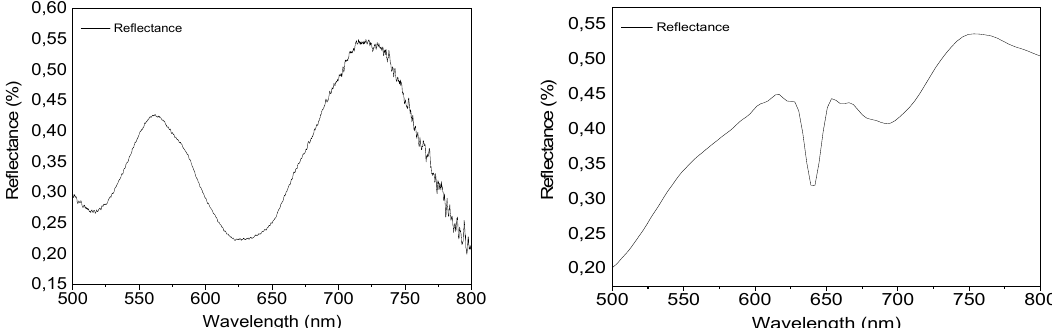
Figure 3. Experimentally measured ( left ) and finite-difference time-domain (FDTD) simulated ( right ) reflectance spectrum of the inverted pyramids.